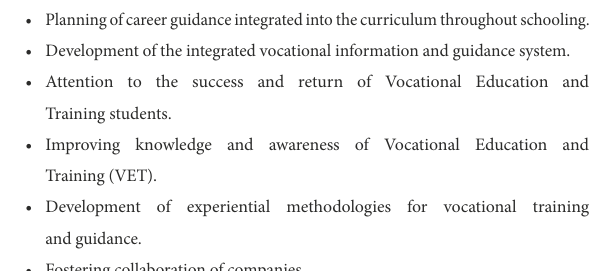
TABLE 1 Challenges for the development of comprehensive career guidance in